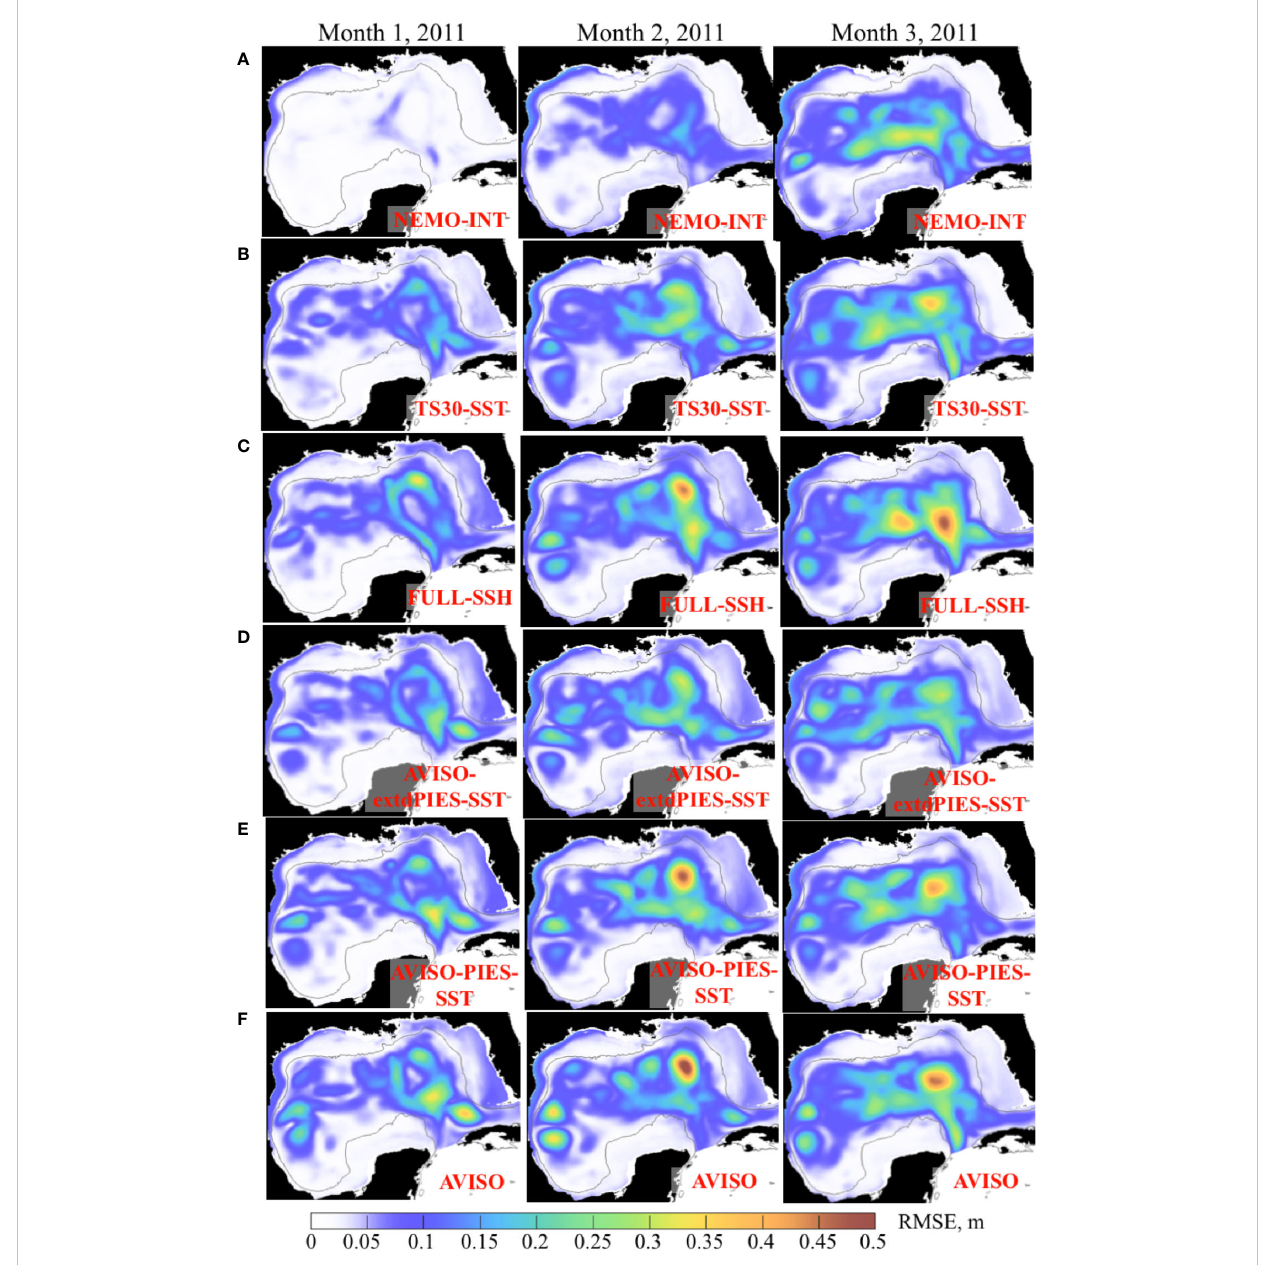
FIGURE 11 Monthly mean RMSE between SSH (m) from the 3-month OSSE forecasts started in May – June 2011 and the NEMO NR. The RMSE for months 1 through 3 are in the columns. The OSSE forecast groups are shown in the rows (A – F) with the forecast names shown in the